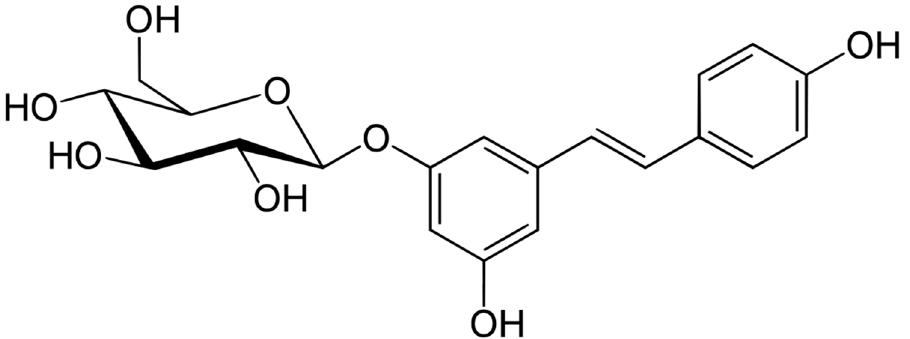
Figure 1. Chemical structure of trans ( A ) and cis ( B ) RSV.